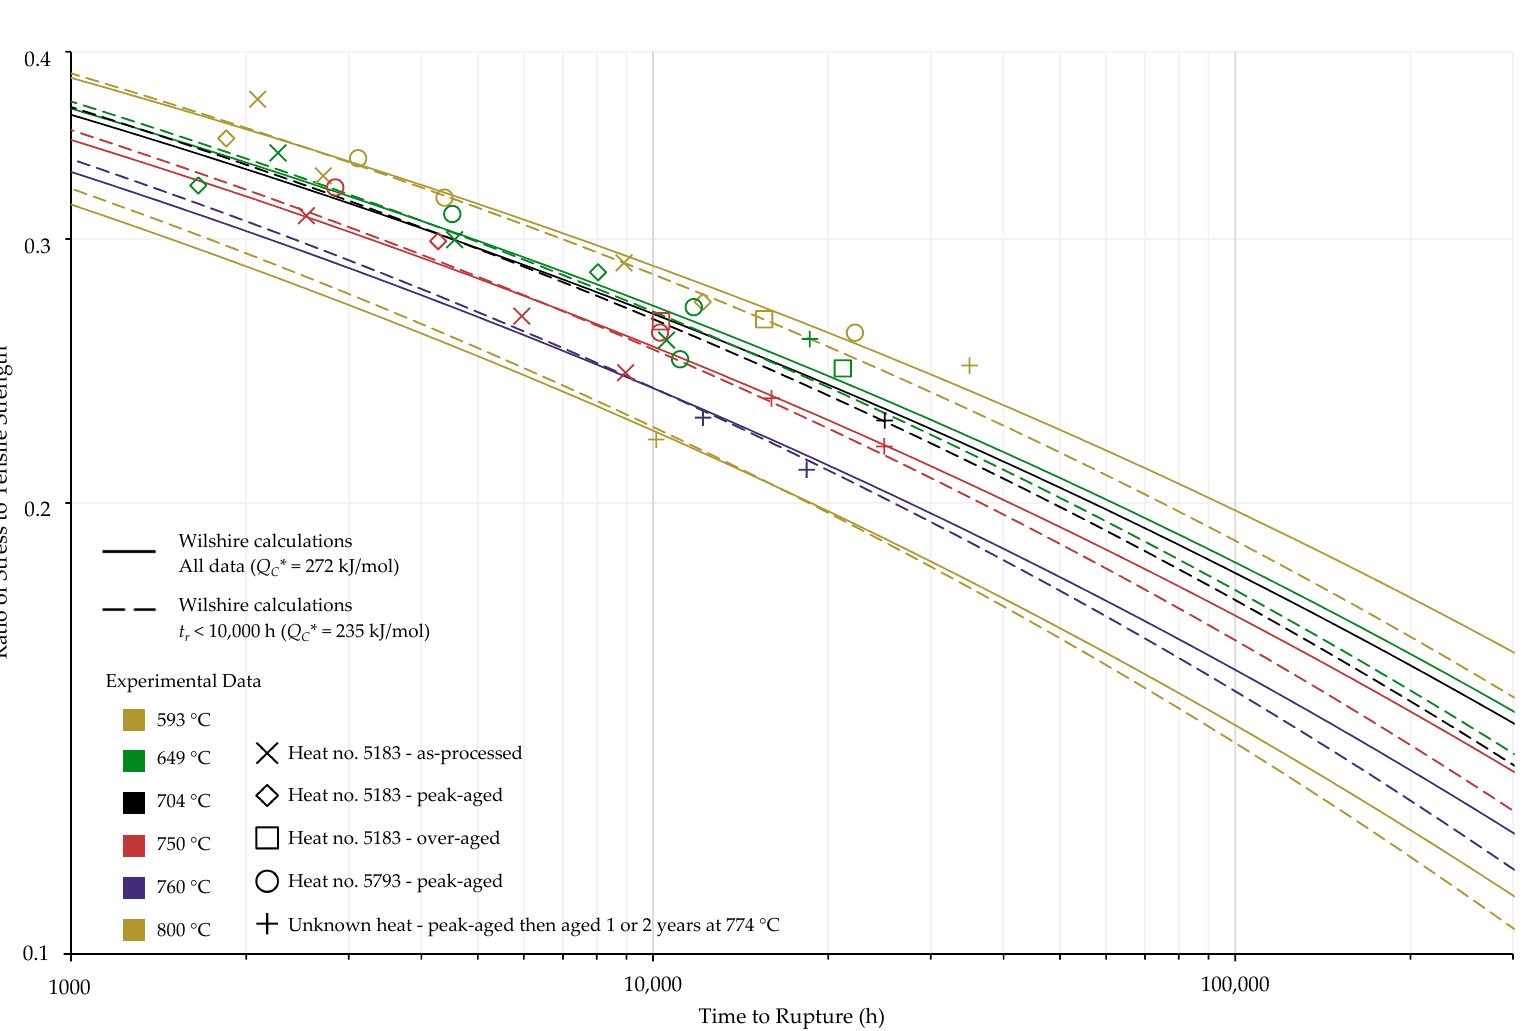
determined by optimizing the C